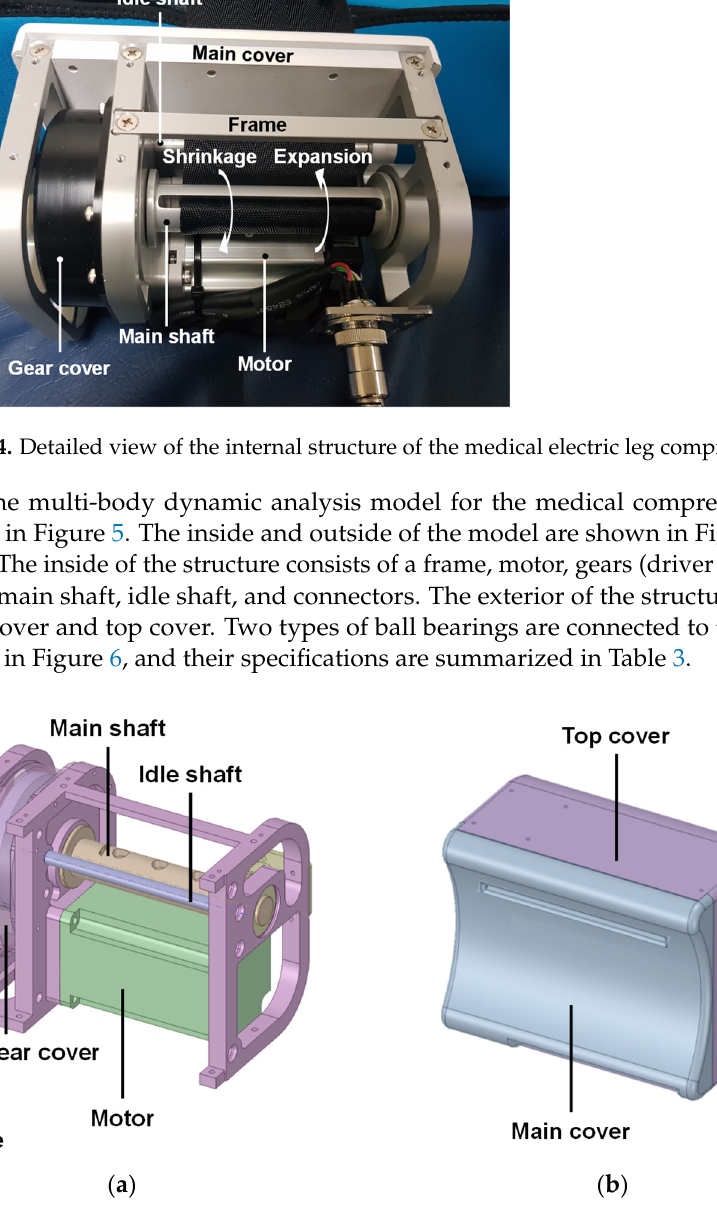
Figure 5. Multibody dynamic analysis model: ( a ) Inner model; ( b ) Outer model.